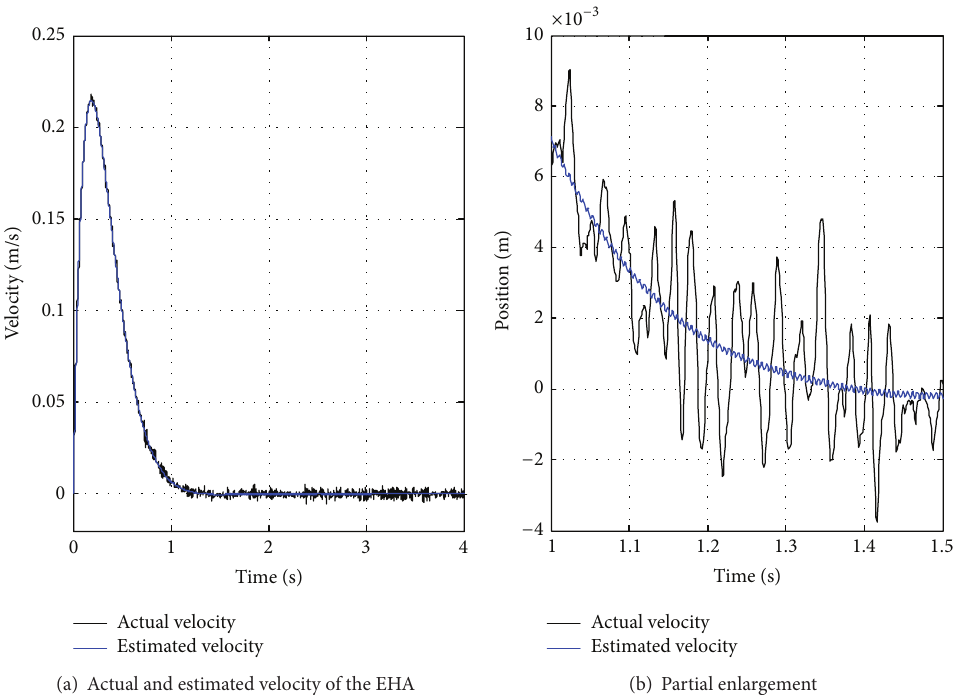
Figure 4: Actual and estimated velocity of the